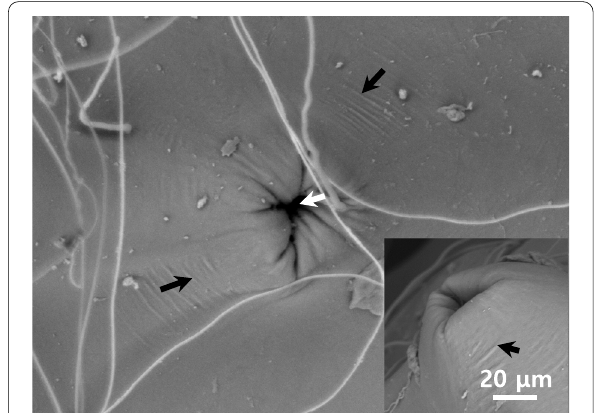
Fig. 3 Scanning electron micrograph of micropyle (white arrow) on the fertilized egg envelopes from Poropanchax normani . But the complete structure of micropyle could not be observed because of the depth in which it is located. The structure around the micropyle was a peak shape with several straight wrinkles (black